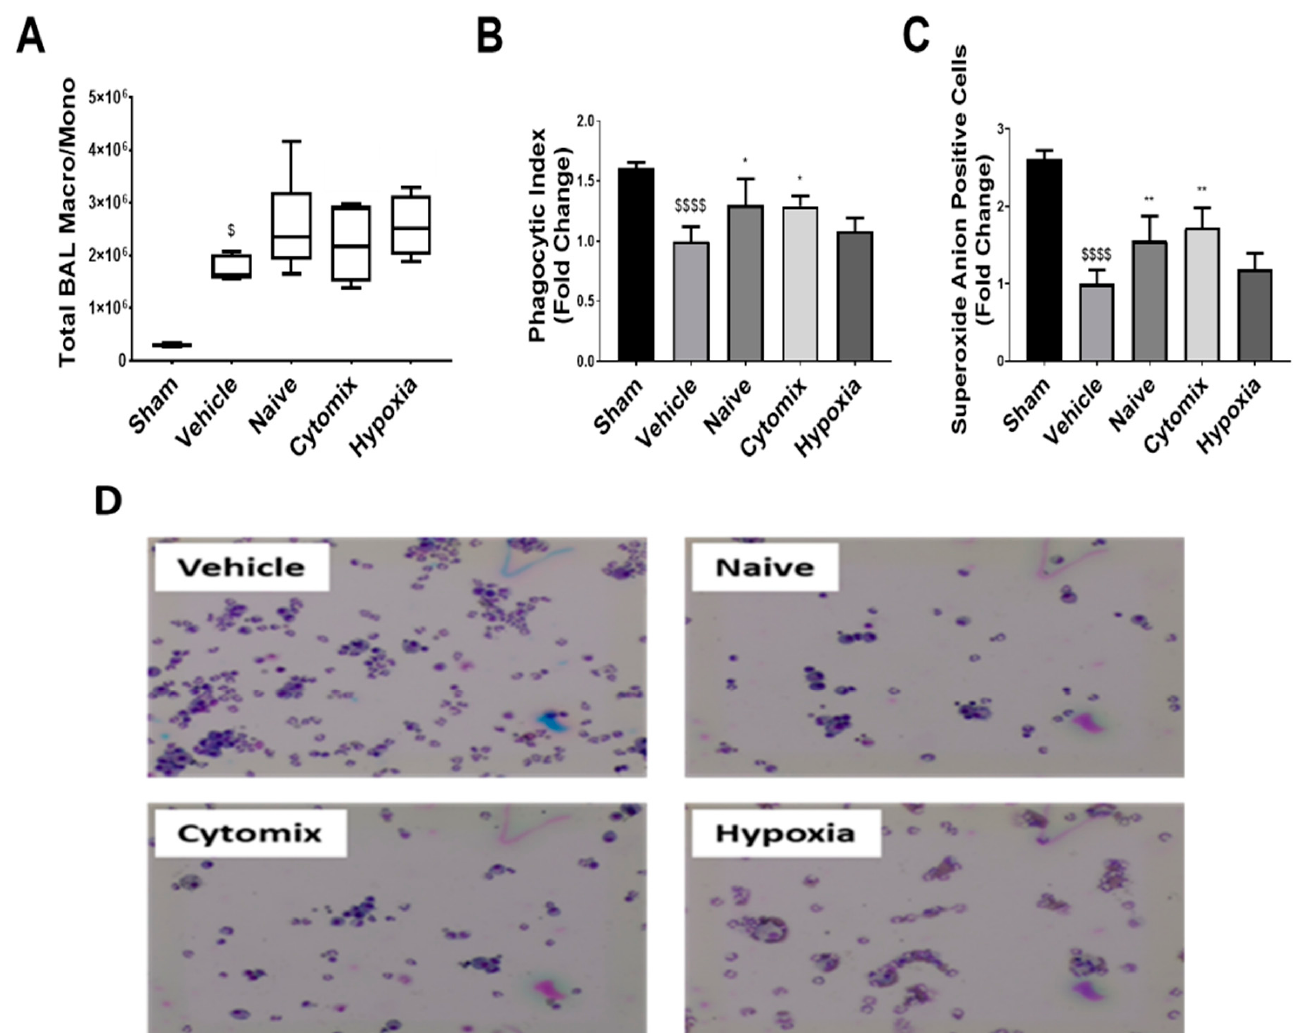
Figure 7. Microscopic analysis of Diff-Quik-stained cytomix BAL cells show an increased infiltration into the alveolar airspace of macrophages/monocytes with the K. pneumoniae injury but no change to the total amount between treatment groups ( A ); representative images of treatment groups are shown ( D ). Adherent BAL macrophage/monocyte phagocytosis ( B ) and superoxide anion production ( C ) revealed a significant reduction in cell function after the injury, with naïve and cytomix-pre-activated MSCs significantly increasing their function. BAL = bronchoalveolar lavage. Box plots and whiskers represent the minimum, first quartile, median, third quartile, and maximum *, ** = p ≤ 0.05, 0.01 with respect to the vehicle control. $, $$$$ = p ≤ 0.05, 0.0001 with respect to the sham group. N = 8–12.